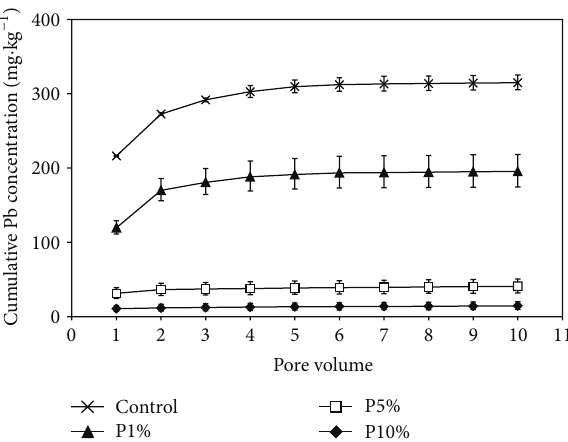
Figure 5: Pb concentration in pore water leached from Pb- contaminated soils amended with peat moss according to time through the microcosm test (control: Pb-contaminated soil without peat moss, P1%: Pb-contaminated soil with 1% peat moss, P5%: Pb- contaminated soil with 5% peat moss, and P10%: Pb-contaminated soil with 10% peat moss).